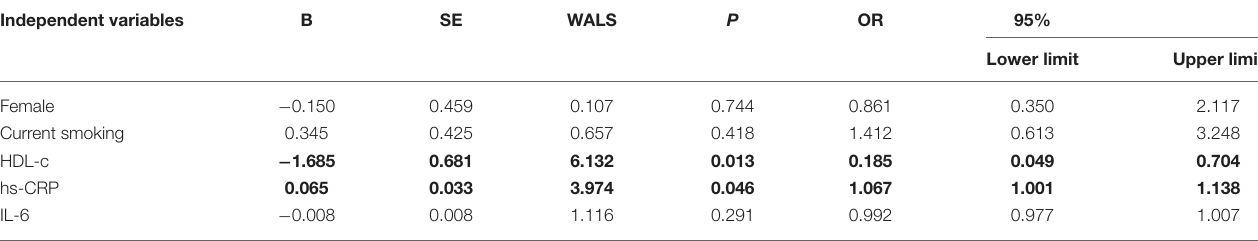
TABLE 4 | Factors associated with the severity of coronary lesions as detected by Gensini Score. Independent variables B